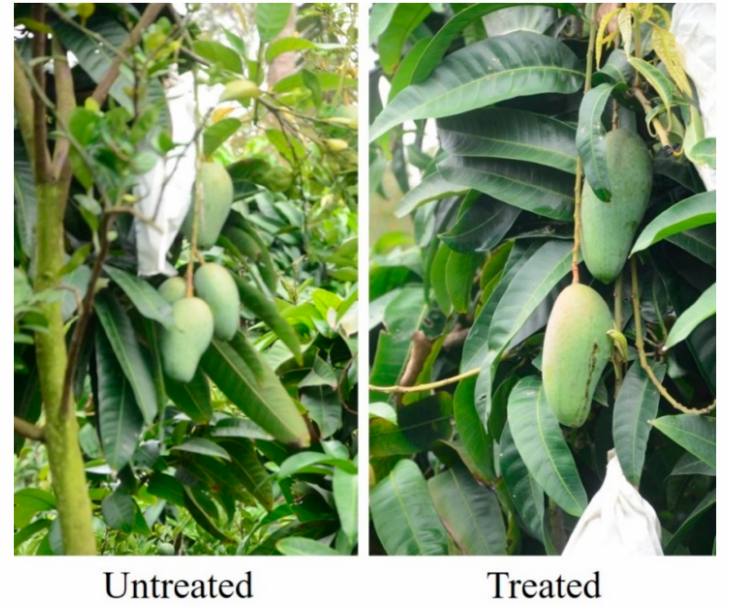
Figure 2. Effect of spraying bloom thinning formulation (BTF) on mango trees. BTF solution (0.1%) was sprayed two times: First at the completion of 80–90% of the blooming season and second during the full-bloom season on 5-year-old mango trees ( n = 15) of the Taiwan strain. At the harvest season (150 days post-treatment), the average fruit number per tree was reduced to 46.3% compared with the control; however, fruit weight was increased to 196.8% compared with the control. The average yield of the treated trees was reduced